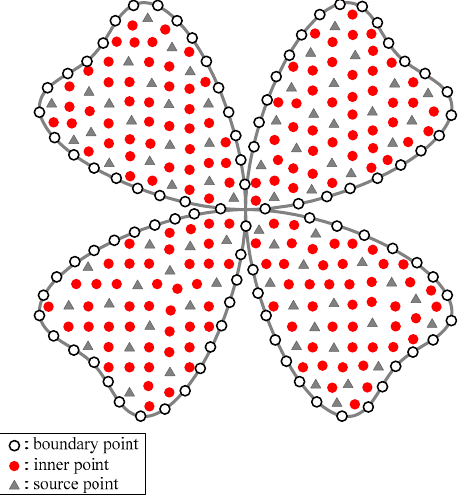
Figure 11. Layout of the boundary, source and inner points.